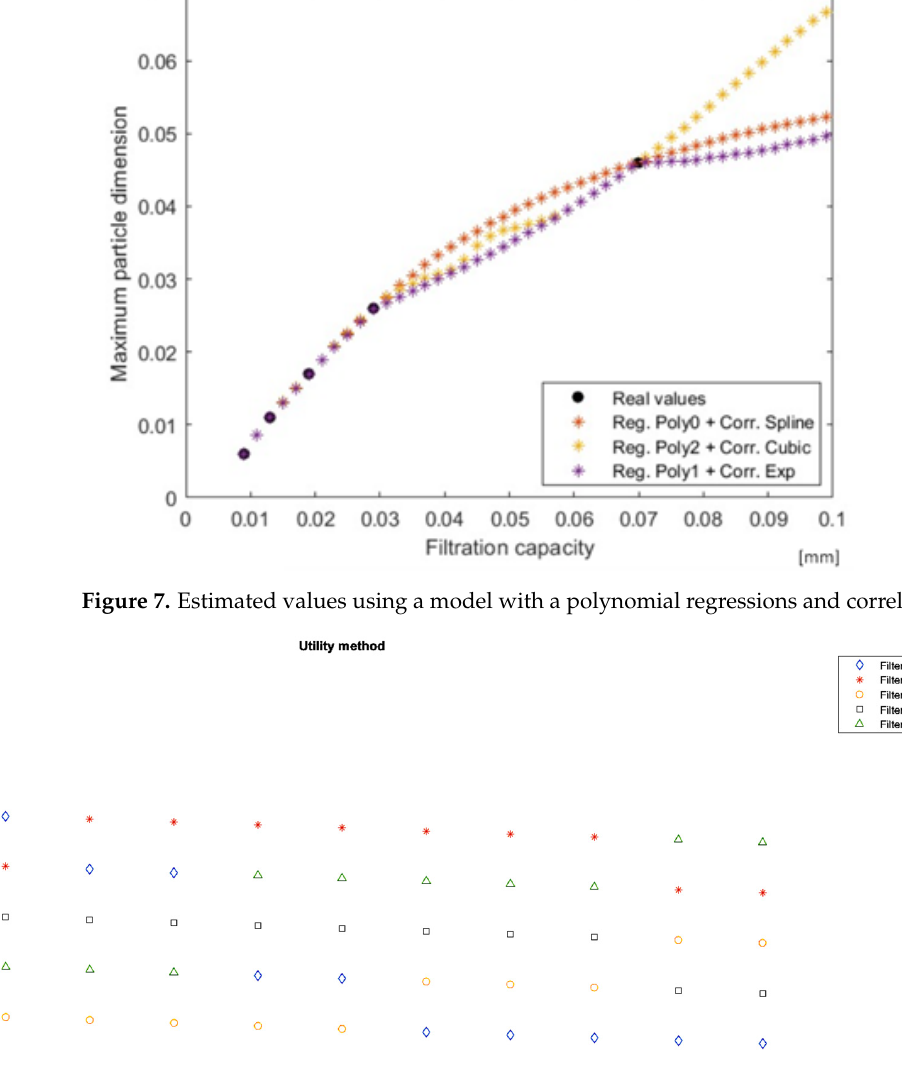
Figure 8. Filter classification with respect to different criteria weight combinations using the Global Utility method.